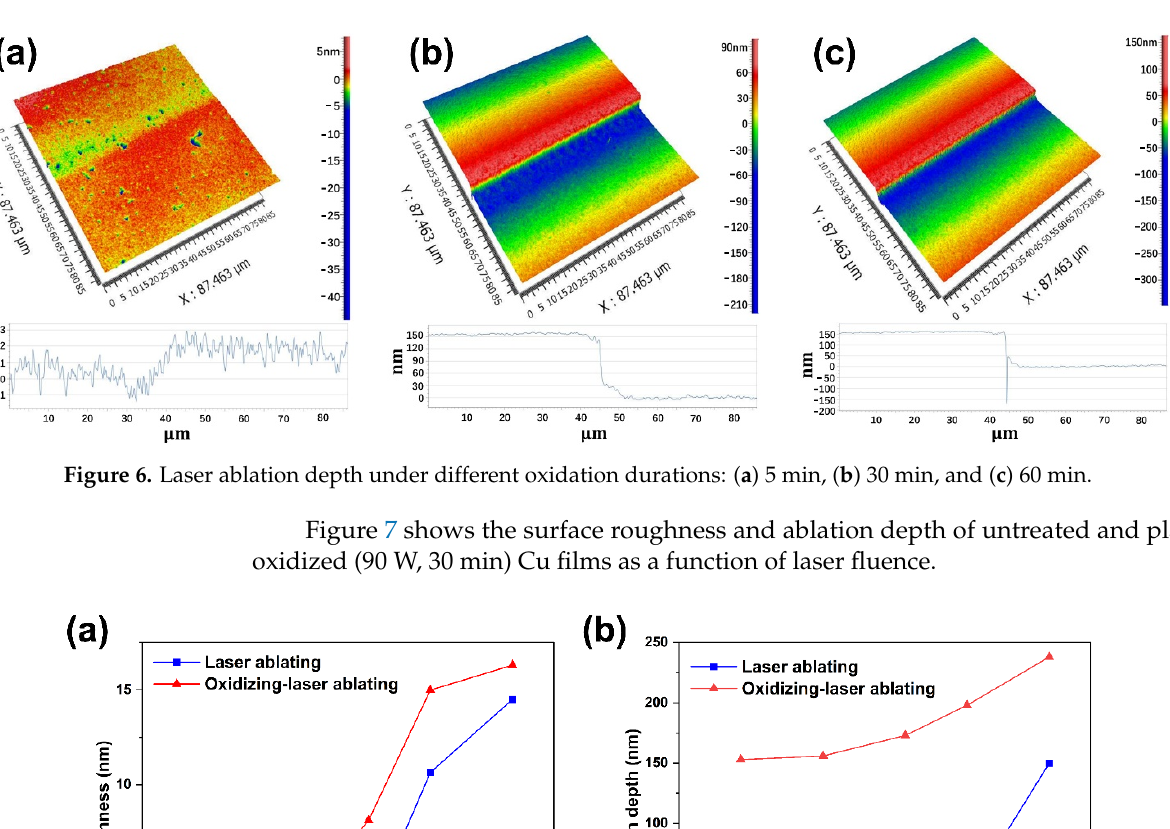
Figure 7. ( a ) Roughness and ( b ) ablation depth of the Cu films obtained by laser ablation and hybrid process under different laser fluences.